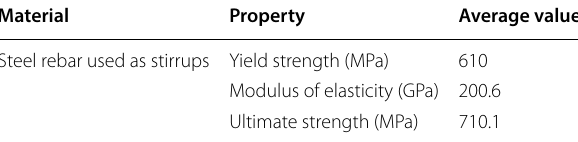
Table 3 Mechanical properties of shear reinforcement.